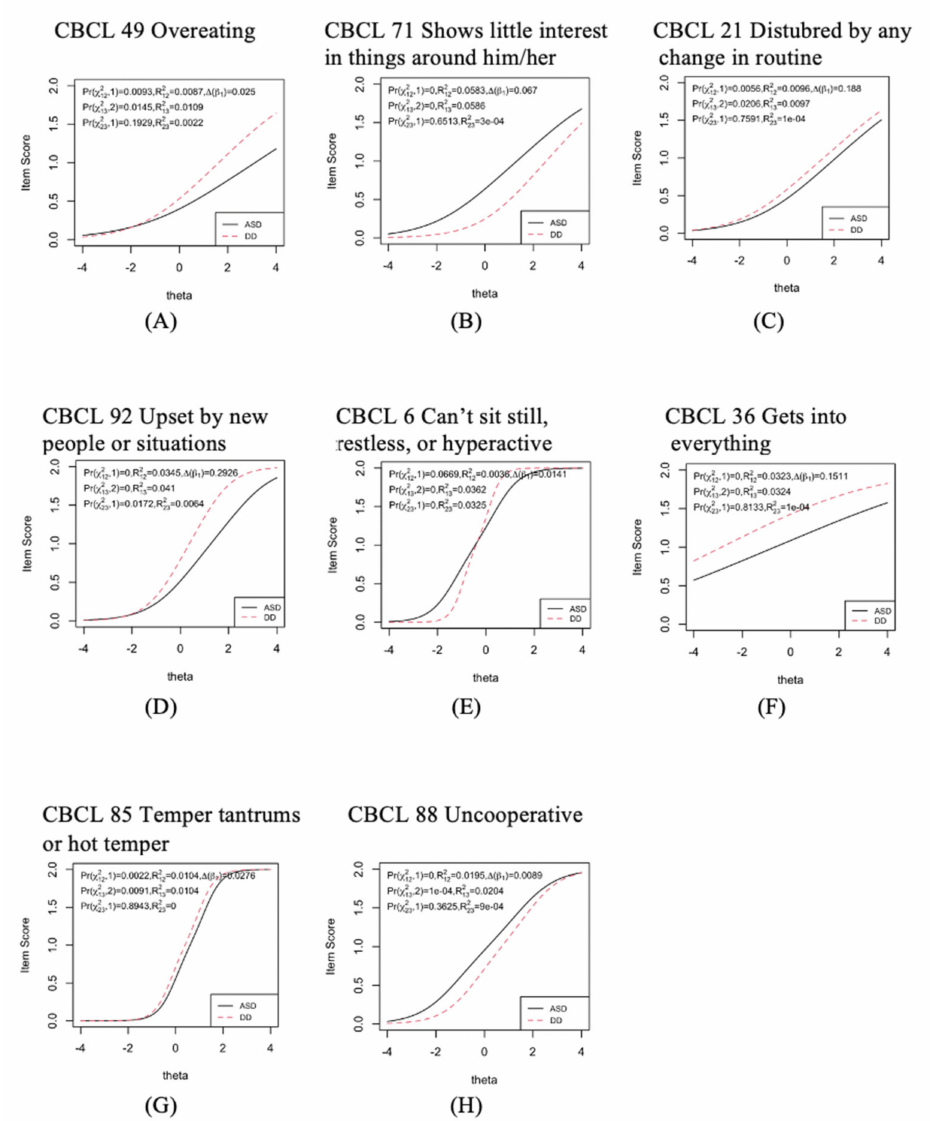
Figure 1. Comparison on DIF items’ score responses between groups across different trait levels. The solid line represents the ASD group. If one line is above another line in that area, this suggests that the above line score is higher. ( A ) The differences between ASD group and DD (higher) group appear to be at high affective problems level; ( B )The differences between ASD (higher) group and DD group are across the spectrum of affective problems; ( C ) The small differences between ASD group and DD(higher) group appear to be at above average PDP level; ( D ) The differences between ASD group and DD (higher) group appear to be at high PDP level; ( E ) The differences between ASD group and DD (higher) group appear to be at both high and low attention deficit hyperactive problems level, but at high level, DD is higher, and at lower level, ASD is higher; ( F ) The differences between ASD group and DD (higher) group are across the spectrum of attention deficit hyperactive problems level; ( G ) The small differences between ASD group and DD(higher) group appear to be at above average oppositional defiant problems level; ( H )The differences between ASD (higher) group and DD group are across the spectrum of oppositional defiant problems, but at lower level the difference is